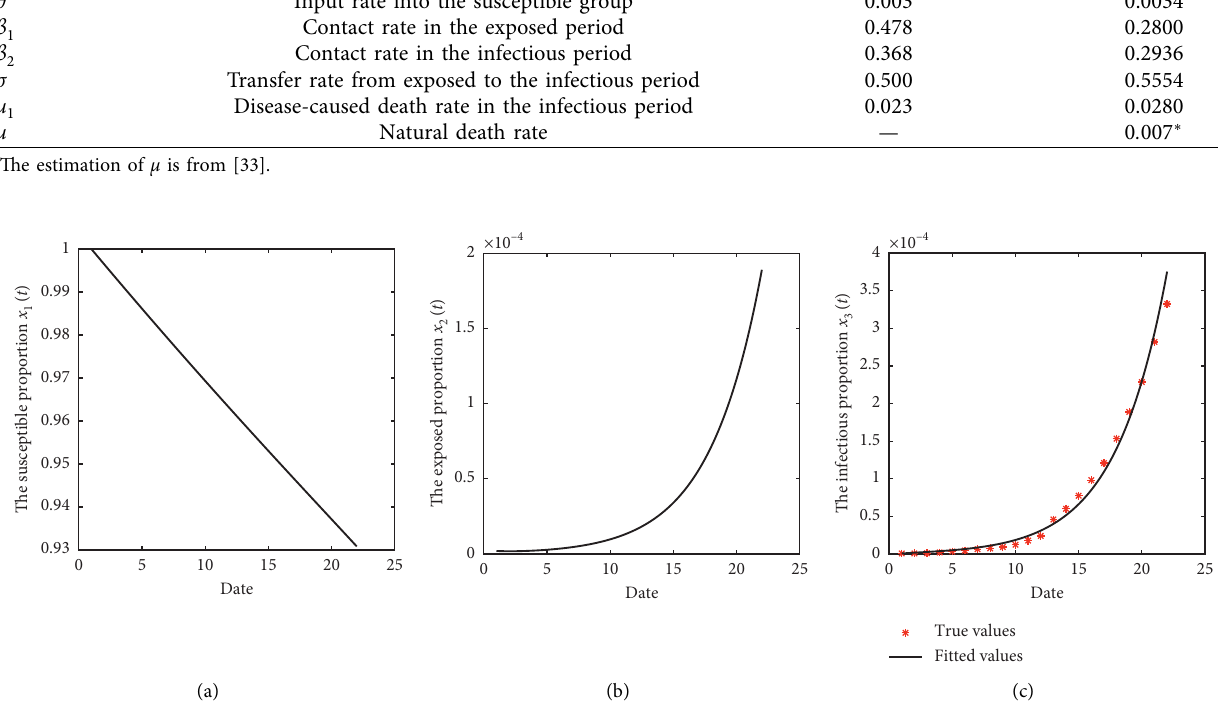
( t ) , (b) fitted curves of x 1